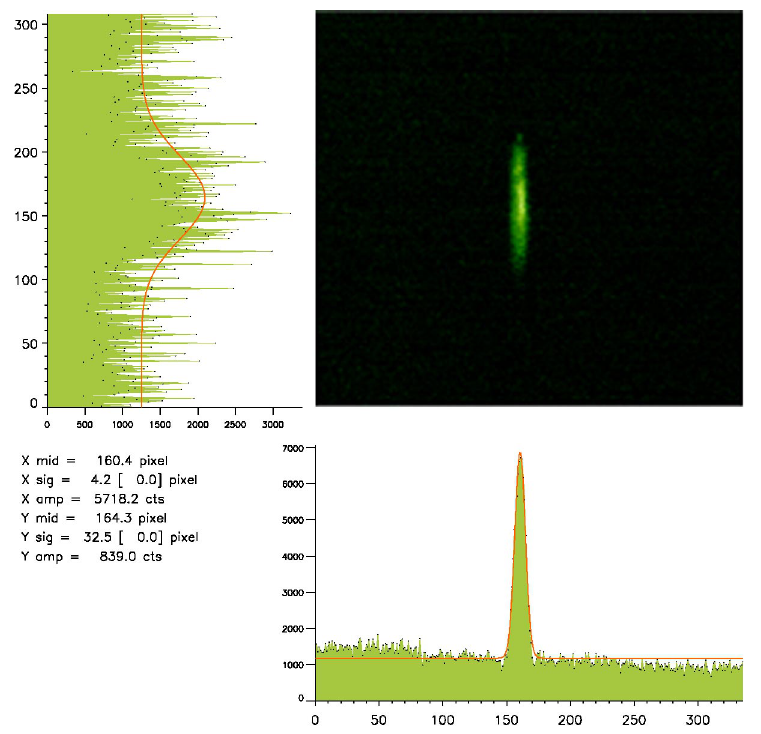
FIG. 4. (Color) Single slit emittance measurement. The beamlet was imaged on a P43 phosphor screen. The histograms show intensity (cid:4) (cid:1) 0 : 138 (cid:6) 0 : 007 (cid:2) mm . This corresponds to an in arbitrary units vs pixel number. The beamlet rms width measured here is (cid:6) x (cid:4) (cid:1) 3 : 54 (cid:6) 0 : 20 (cid:2) mrad at the slit location. uncorrelated beam divergence spread of (cid:6) x 0